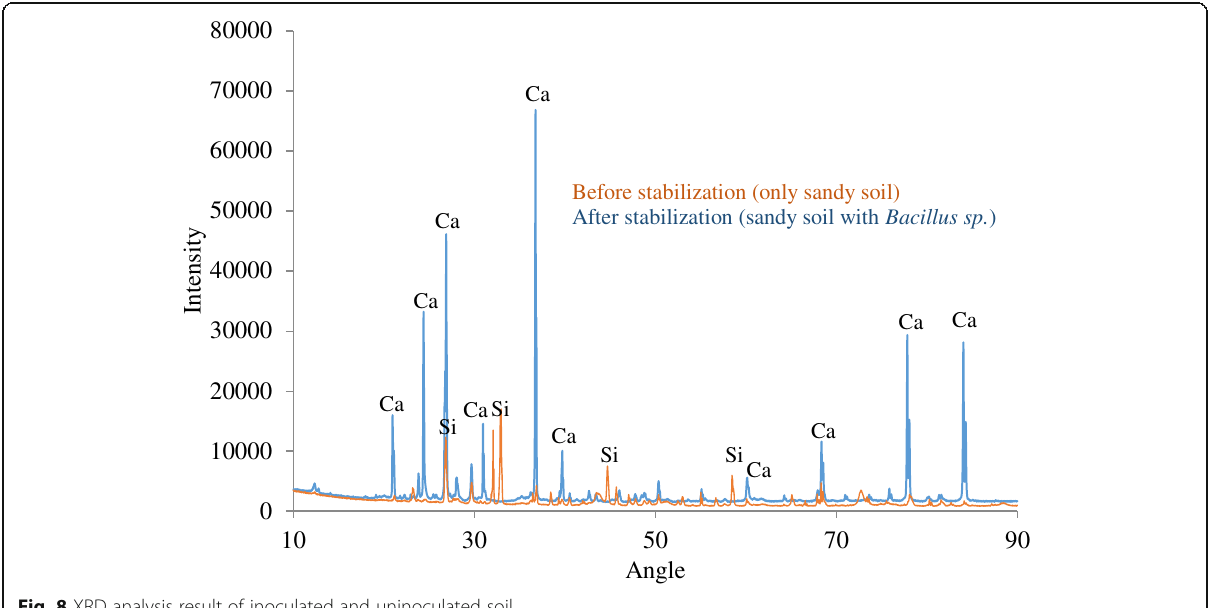
Fig. 8 XRD analysis result of inoculated and uninoculated soil